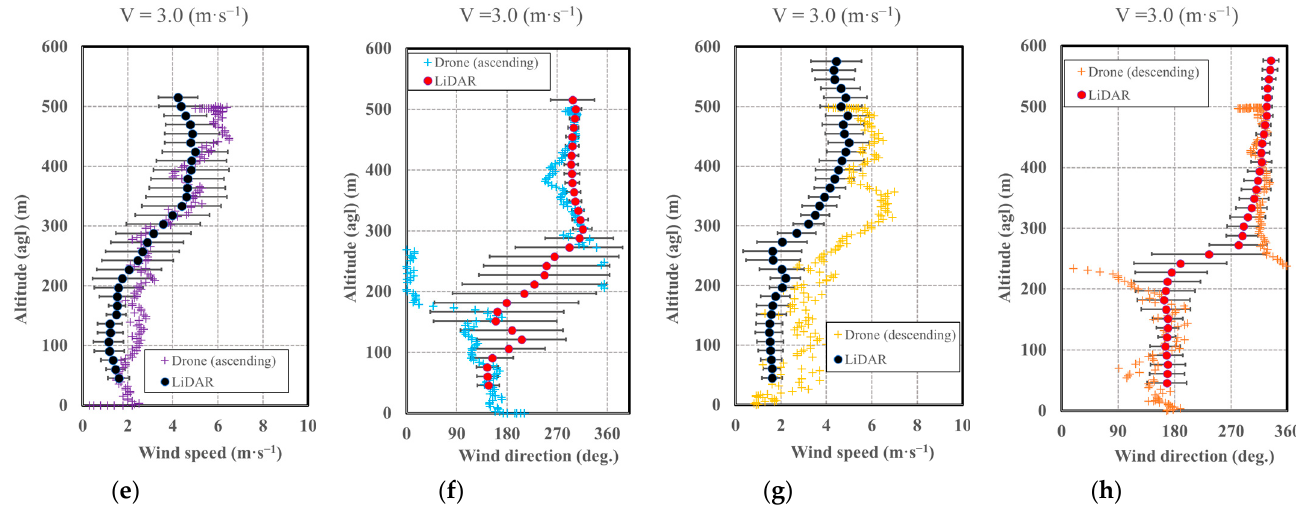
Figure 7. Comparison of vertically moving drone and LiDAR observations: ( a – d ) V = 1.0 m·s − 1 ; ( e – h ) V = 3.0 m·s − 1 ; ( a , c , e , g ) wind speed; ( b , d , f , h ) wind direction; ( a , b , e , f ) with ascending drone; and ( c , d , g , h ) with descending drone for Runs B-1 and B-3. The error bars represent the standard deviation of LiDAR measurements during the ascending and descending time periods of the drone.